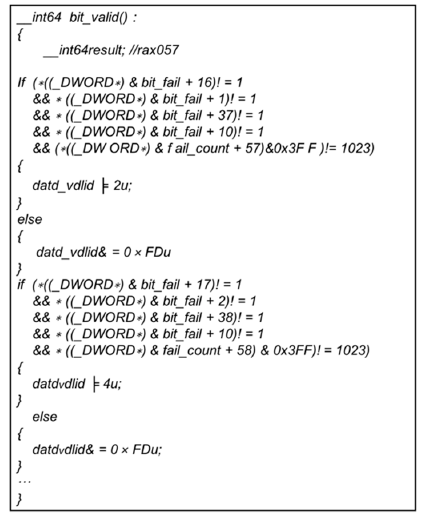
Figure 10. Obtained C code.